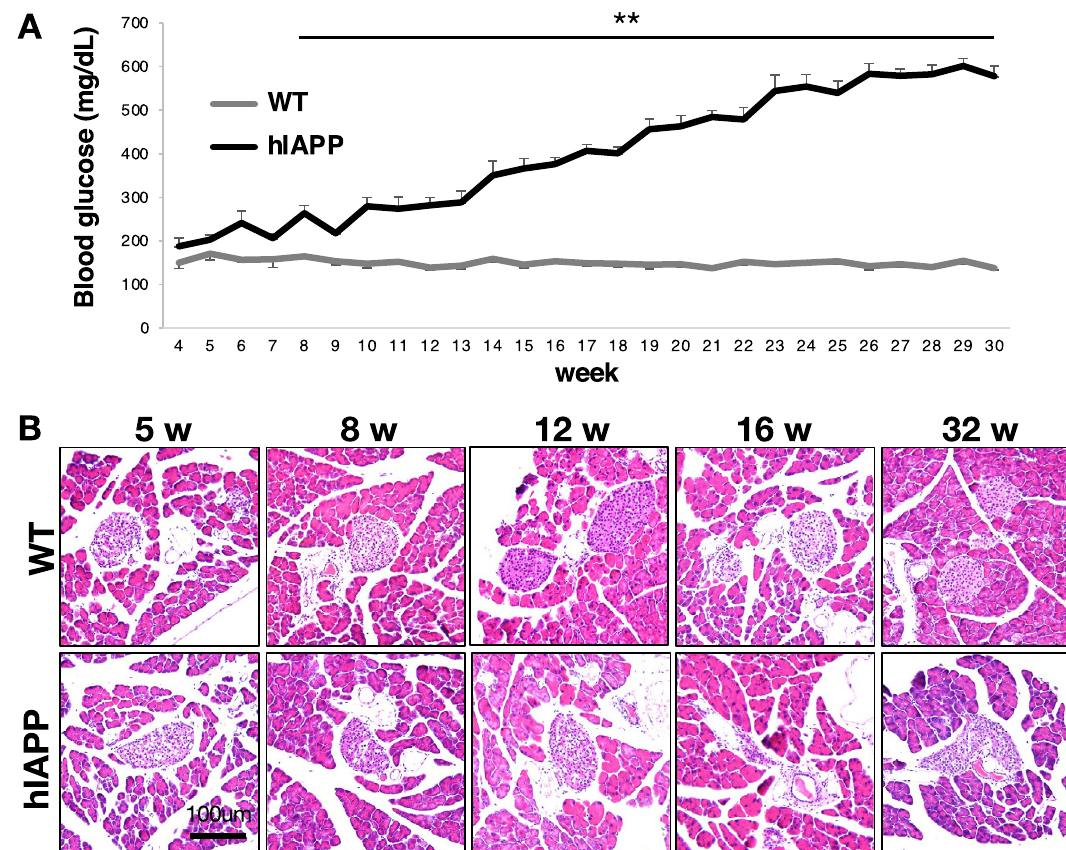
Figure 1. Phenotype of hIAPP-Tg mice. ( A ) Non-fasting blood glucose levels of WT mice (n = 3–11) and hIAPP-Tg mice (n = 4–9). ( B ) HE staining of pancreas sections from 5-, 8-, 12-, 16-, and 32-week-old hIAPP-Tg mice and WT mice. Data are shown as the mean ± SEM. ** p < 0.01 (WT vs. hIAPP). Scale bar, 100